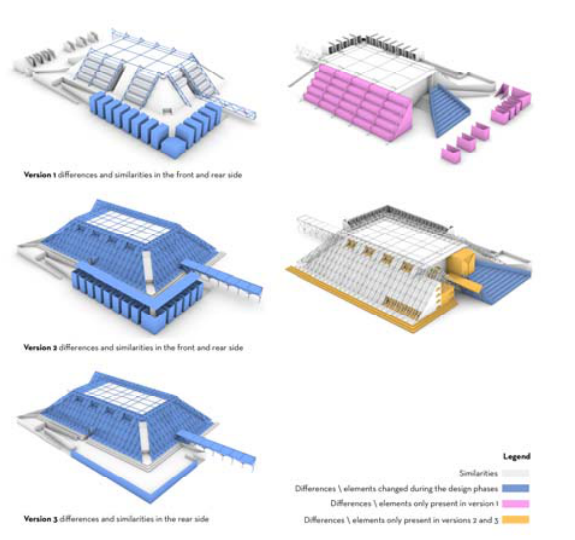
Figure 3 . The evolution of the architectonical